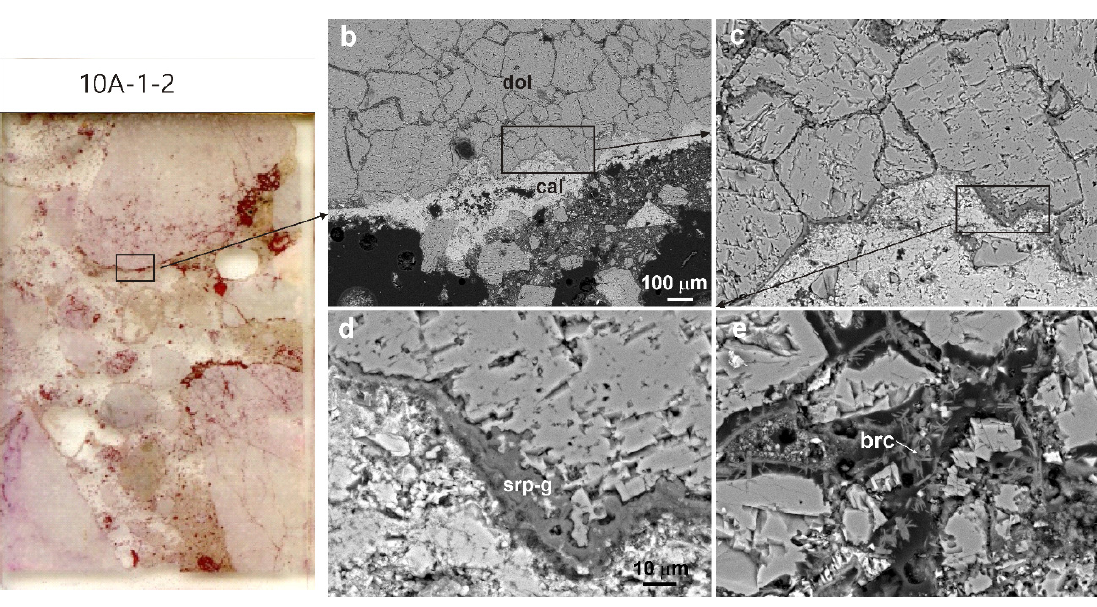
Figure 10. ( a ) Image of a thin section of the type B concrete stained with red alizarin; ( b ) SEM images of type B concrete that show the development of calcite and a rim of a serpentine group mineral; ( c,d ) details of this rim; ( e ) development of brucite in the sand-cement paste.